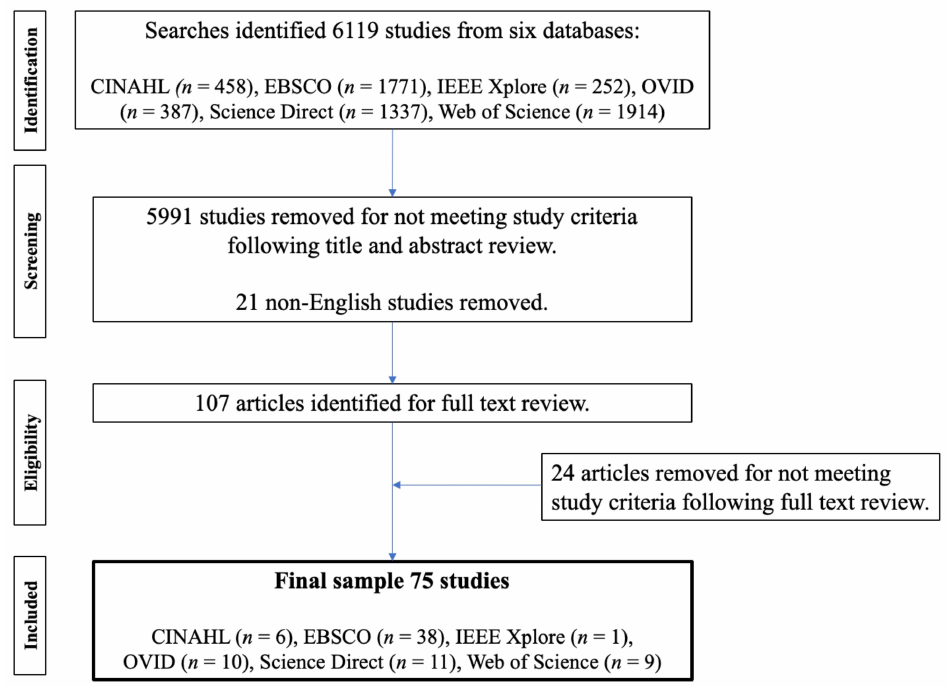
Figure 1. PRISMA flowchart for this